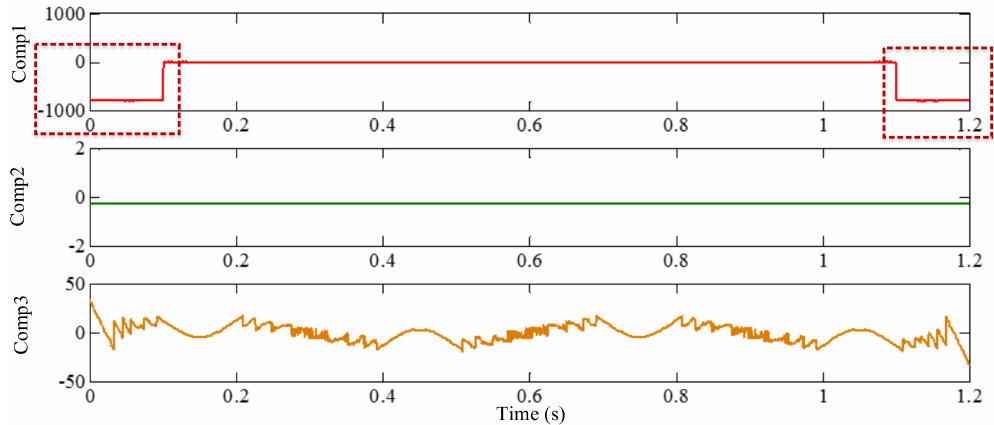
Figure 43. The STFT of the sample signal f sig 9 : ( a ) 2D figure and ( b ) 3D figure.